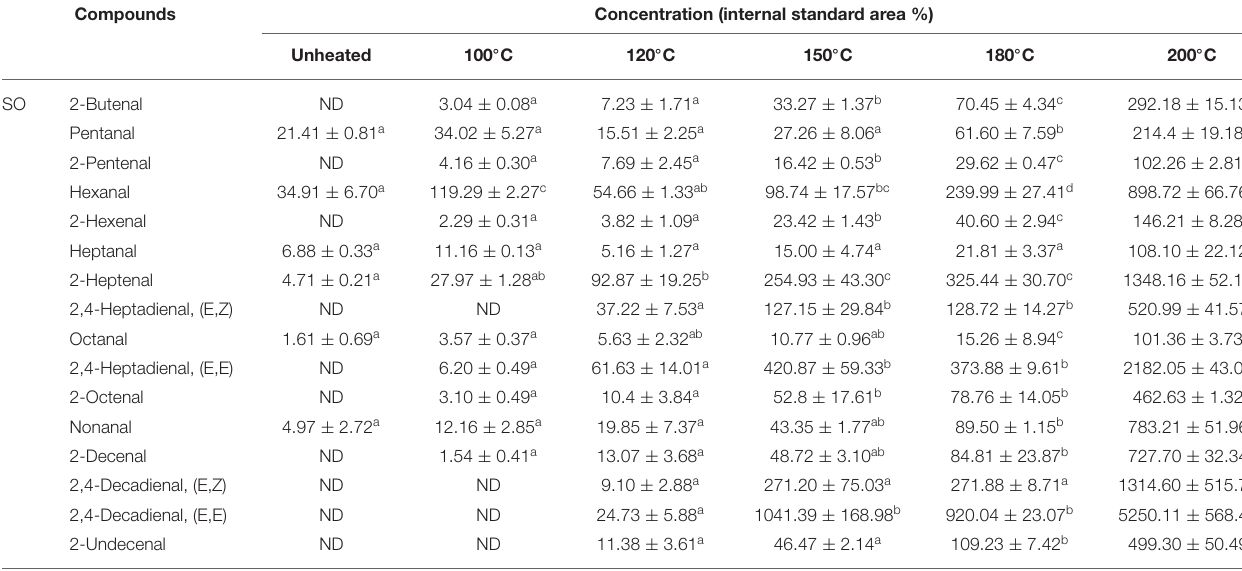
TABLE 1 | Changes in the volatile oxidation products of SO at different heating temperatures. Compounds